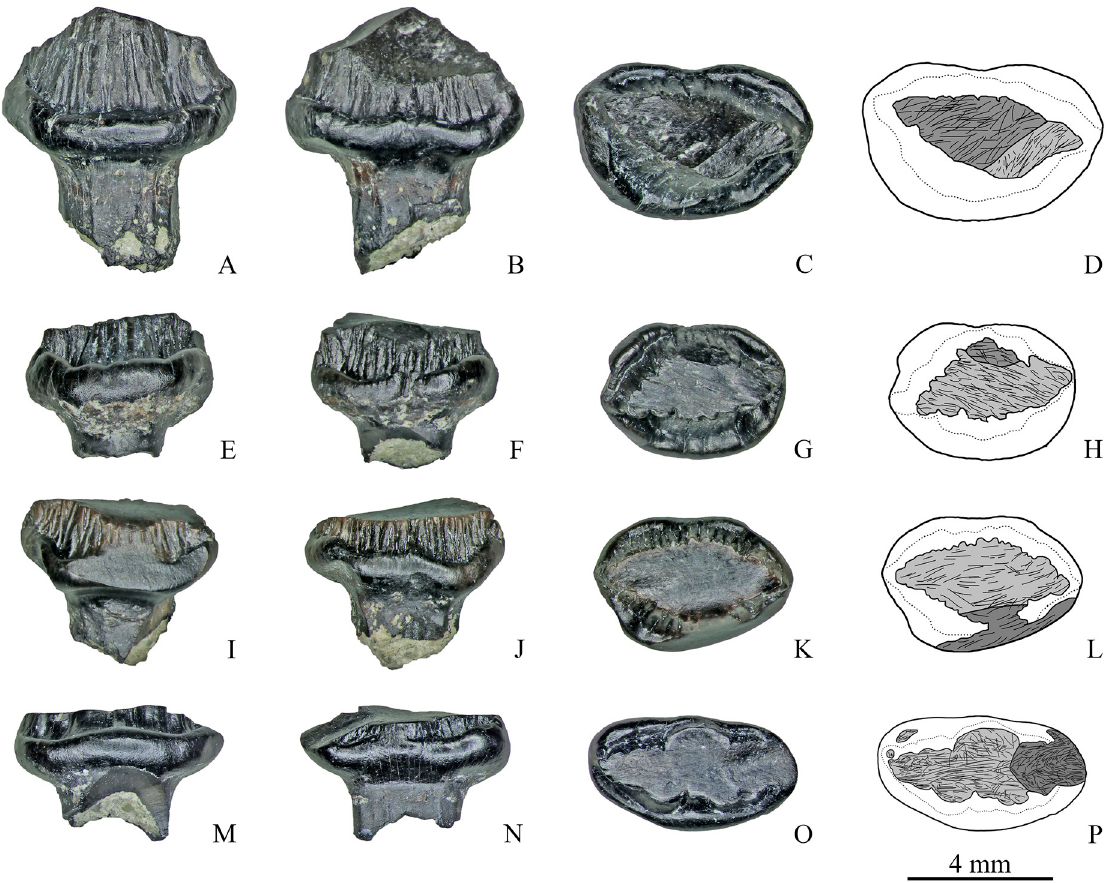
Fig 5. Maxillary teeth with two wear facets of Stegosauria indet. from the Teete locality, Yakutia, Russia; Batylykh Formation (Lower Cretaceous). Specimens ZIN PH 28/246 (A-D), ZIN PH 31/246 (E-H), ZIN PH 53/246 (I-L), ZIN PH 69/246 (M-P) in labial (A, E, I, M), lingual (B, F, J, N), occlusal (C, G, K, O) views, and interpretive drawings (D, H, L, P) in occlusal views showing the wear facets with scratches.